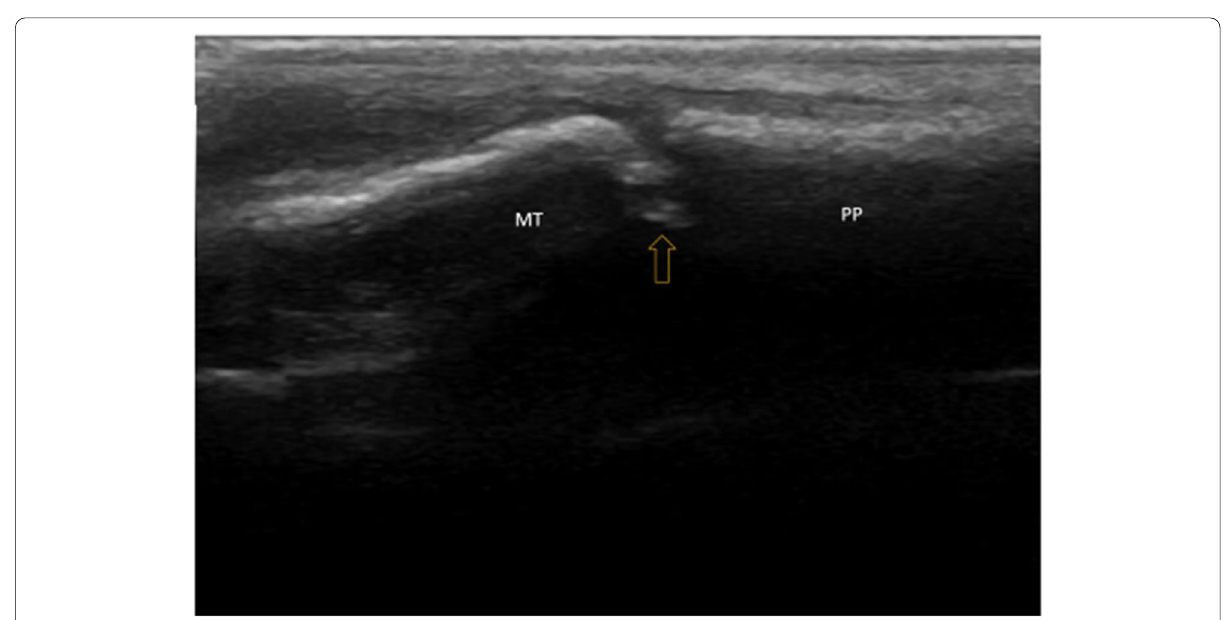
Fig. 3 Dorsal longitudinal gray scale ultrasound scan of the first MTP joint showing erosion